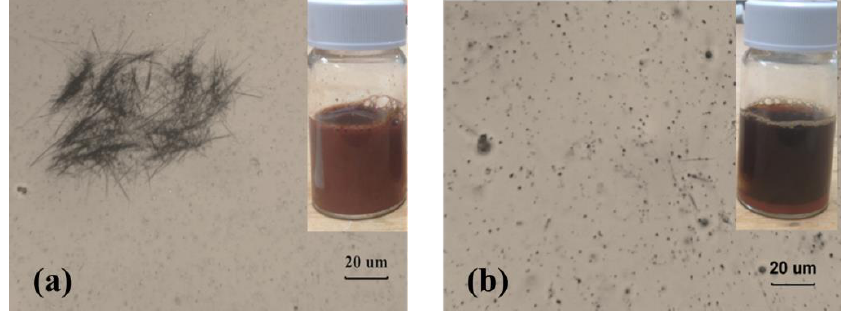
Figure 4. The homogeneity of CuNWs in suspension ( a ) without dispersion agent, ( b ) with 1 wt% PEG-7.